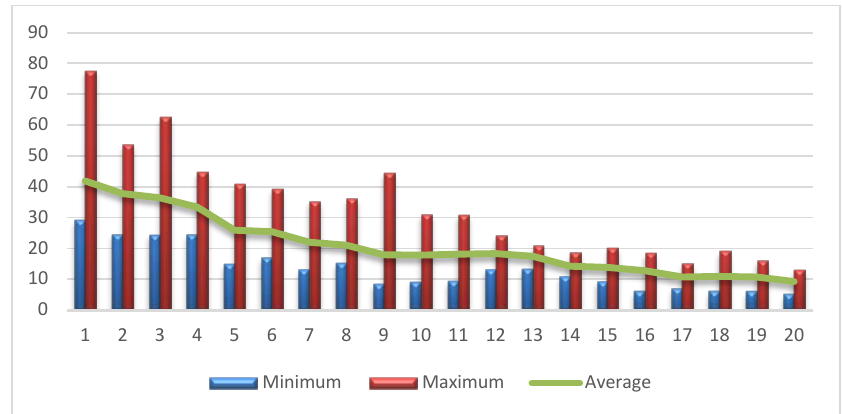
FIGURE 2: Minimum and Maximum Number of Shares in Each Portfolio Source: own